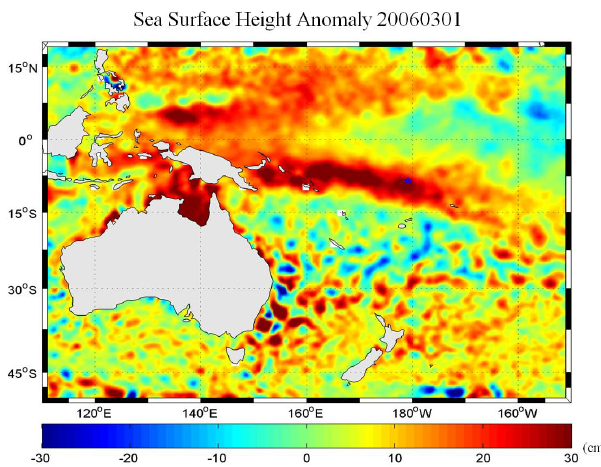
Fig. 6. A map of sea surface height anomaly during a King Tide event. The blue star indicates the position of Tuvalu. Color bar shows the sea surface height anomaly by centimeter. Red color presents the warm-water effect, while blue presents the cold-water effect. The image is a 7-day average datum. The date on the image is the middle date of the 7